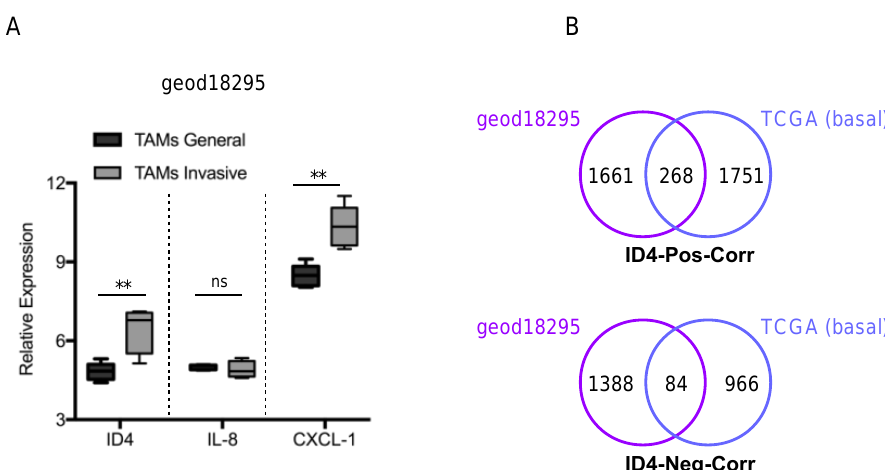
Figure 4. ( A ). Expression of ID4 and CXCL1 mRNA is higher in macrophages associated with invasive tumor cells (PyMT mammary tumors), compared to general TAMs, in the E-GEOD-18295 dataset. ** ( p < 0.005) p -values were calculated by a two-tailed t-test. ns: not significant. ( B ). Venn diagrams showing the number of mRNAs commonly correlated to ID4 ( p > 0.05) in the E-GEOD-18295 dataset and in basal-like tumors of the breast cancer TCGA dataset.